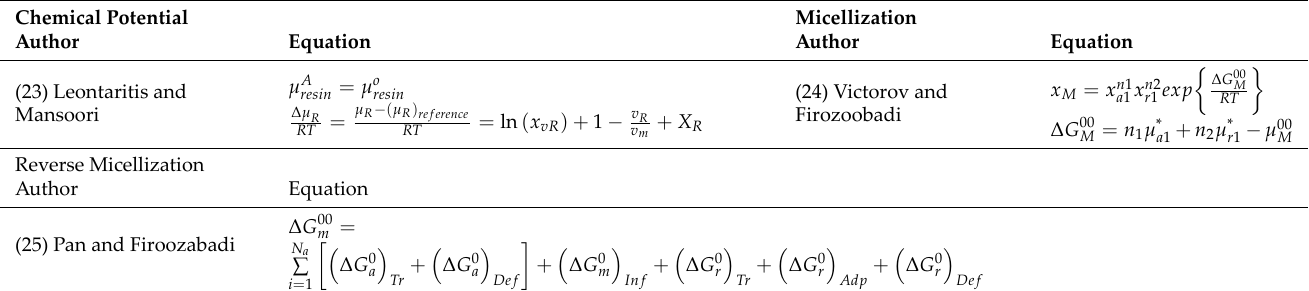
Table 4. Models to calculate asphaltene precipitation based on the colloidal approach (Chemical Potential, Micellization, and Reverse